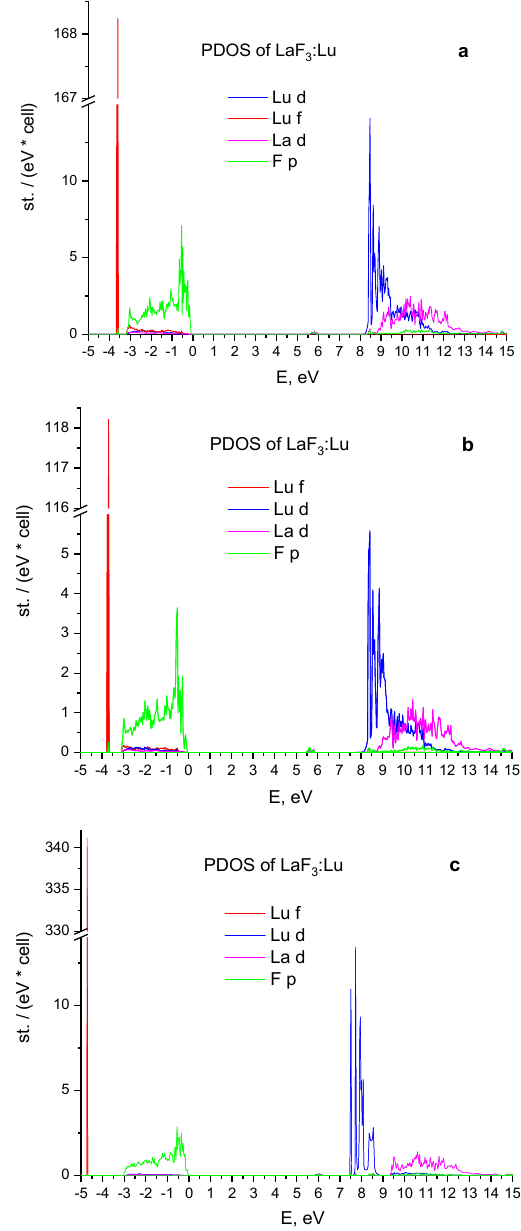
Figure 1. The influence of crystal structure optimization on the partial density of states (PDOS) after the substitution of the La ion by the Lu ion in the LaF 3 host: ( a ) The change of the ion positions with fixed lattice volume; ( b ) the change of the lattice volume without changing of the ions position; ( c ) without relaxation.